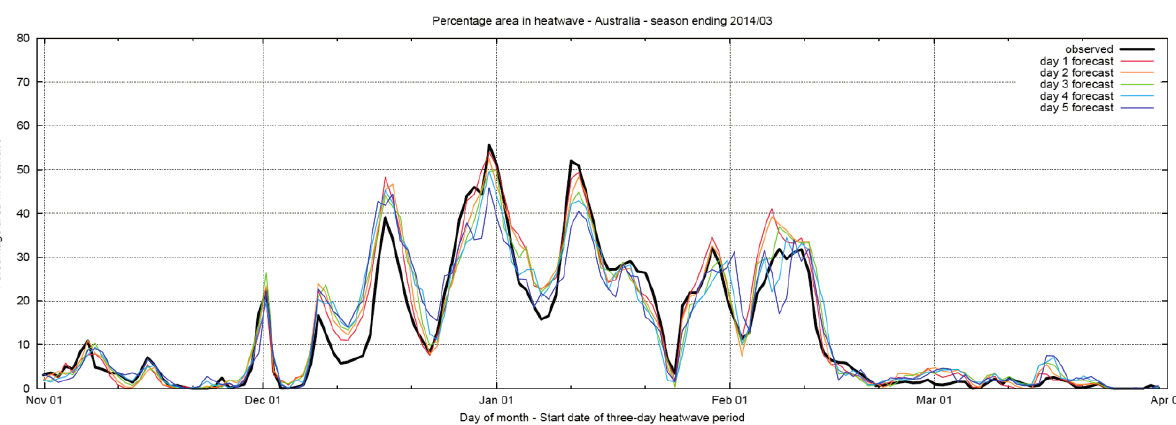
Figure A1. Heatwave observational analysis for the TDP 1 to 3 January 2014. The map shows the EHF expressed as a multiple of the severity threshold EHF four categories; no heatwave (white), non-severe or low-intensity heatwave (yellow), severe but not extreme heatwave (orange), and extreme heatwave (red). The forecasts were issued in largely the same format.